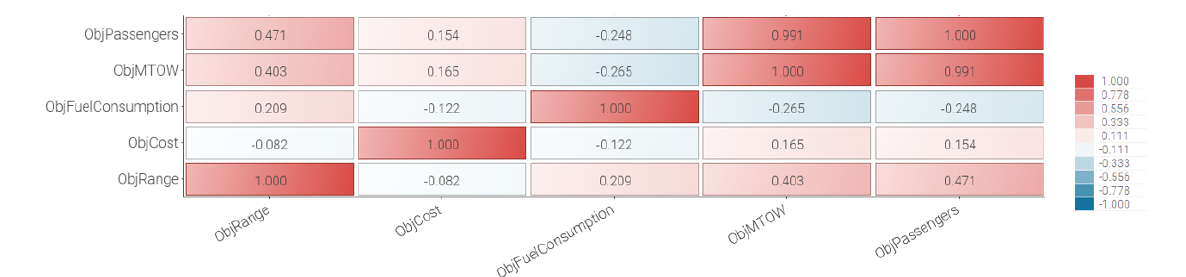
Figure 8. A system characteristics correlation matrix illustrating the relationships between the optimization